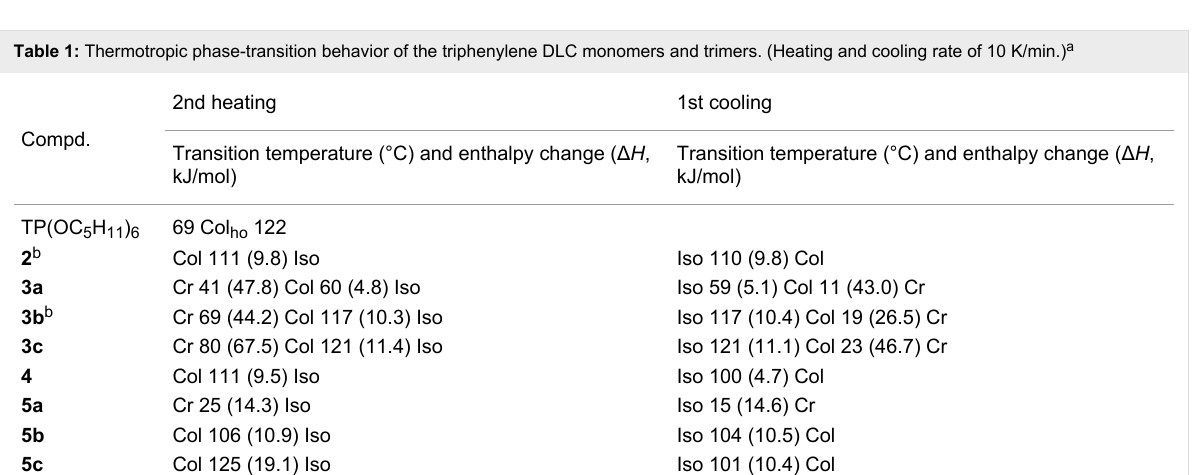
Figure 3: The DSC traces of the triphenylene DLC monomers and trimers. (A) 2nd heating traces; (B) 1st cooling traces. Scanning rate 10 K/min.